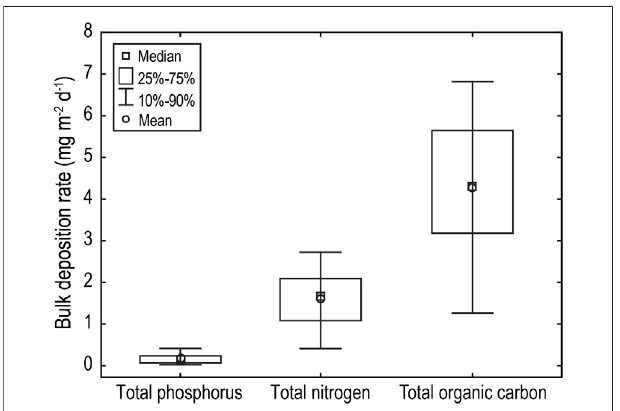
FIGURE 6 | Average daily bulk atmospheric deposition of macronutrients (TP, TN and TOC) to Little Nerang Dam over a 10 month monitoring period from Febuary to December